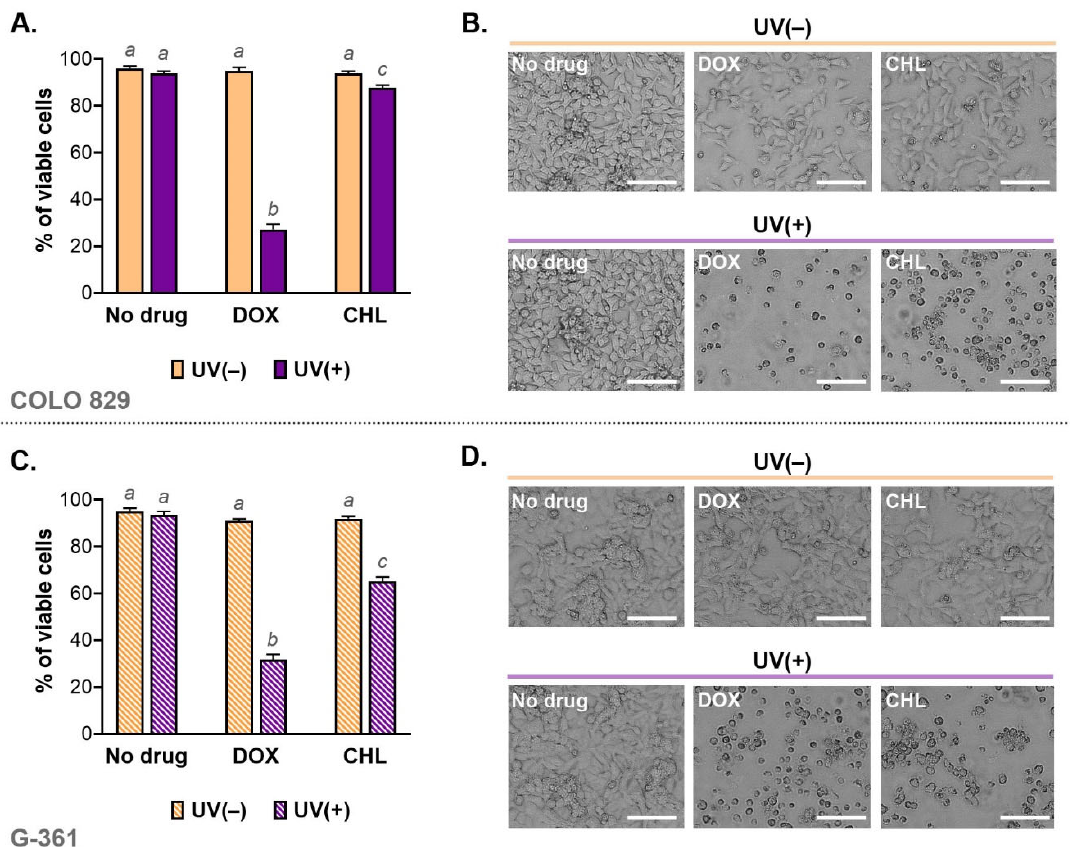
Figure 2. Viability of melanoma cells exposed to doxycycline and chlortetracycline as well as UVA radiation ( A , C ). The results were expressed as mean values ± SD. Sample microscopic images showing morphology of the tested melanoma cell cultures after the investigated treatment ( B , D ). Scale bar 250 µm. Using different letters to show statistical significance.